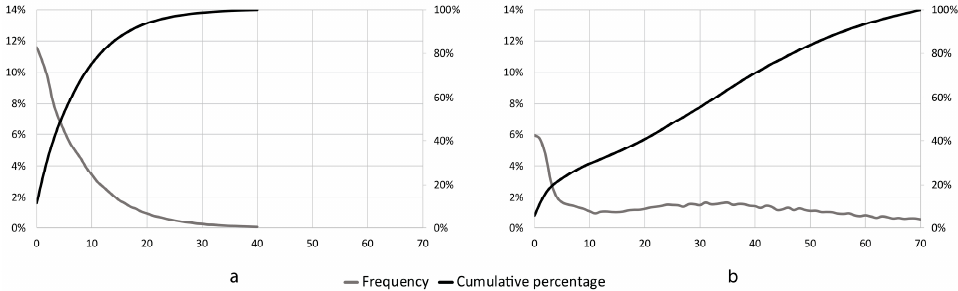
Figure 3. Frequency and cumulative percentages for passenger volumes at stations with a scheduled dwell time of 42 s ( a ) and 120 s ( b ).